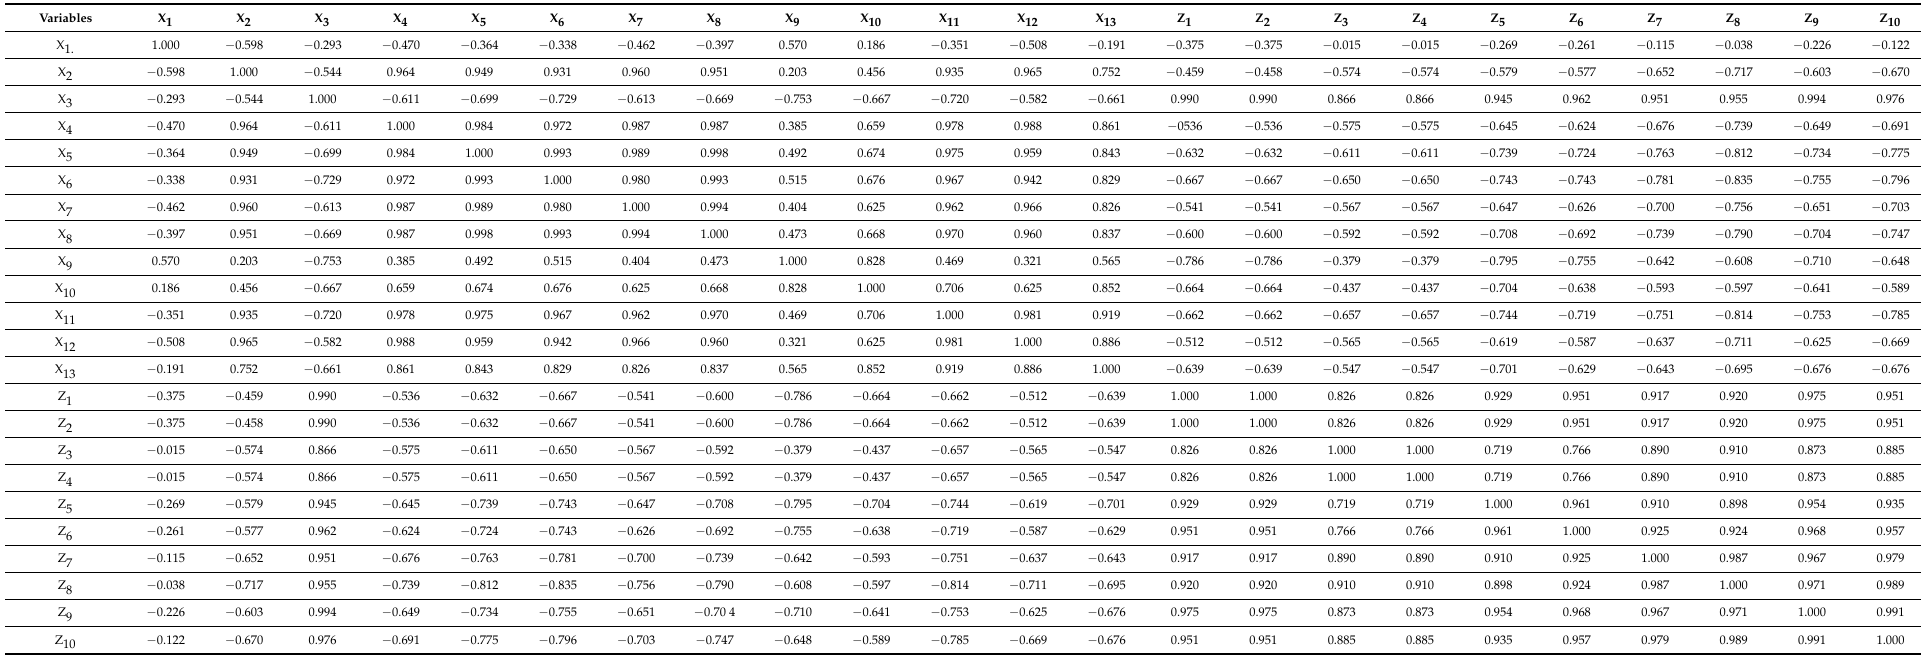
Table A6. Correlation matrix of variables describing field crop